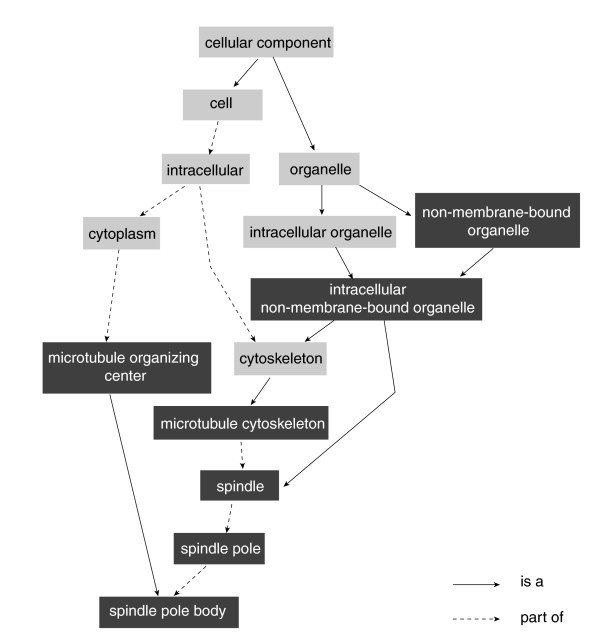
GO analysis of detected antisense transcripts. Dark squares indicate statistically significant over-representation of GO terms among 732 antisense transcripts with assigned GO annotations (see text and Table 4 for details; a list of expressed 'spindle pole' and related genes are given in Additional data file 7).